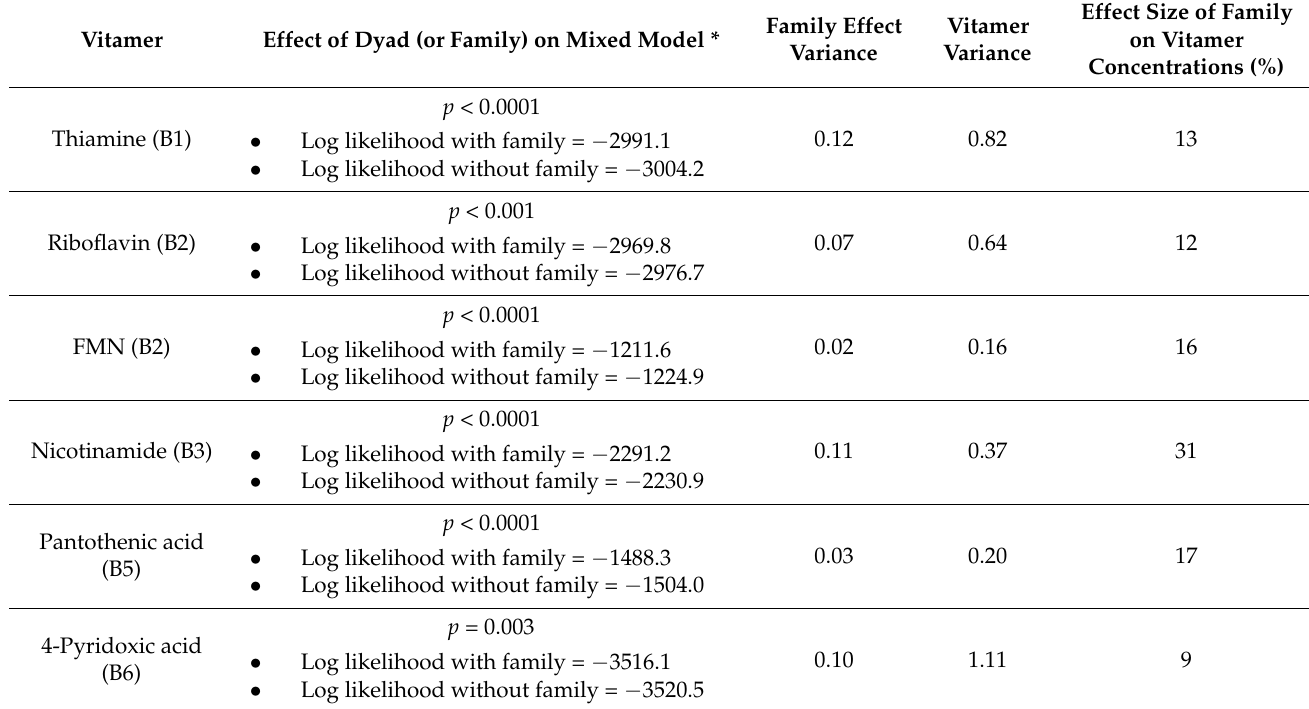
Table 2. Mixed model results, variances and effect sizes of family on B vitamer concentrations.